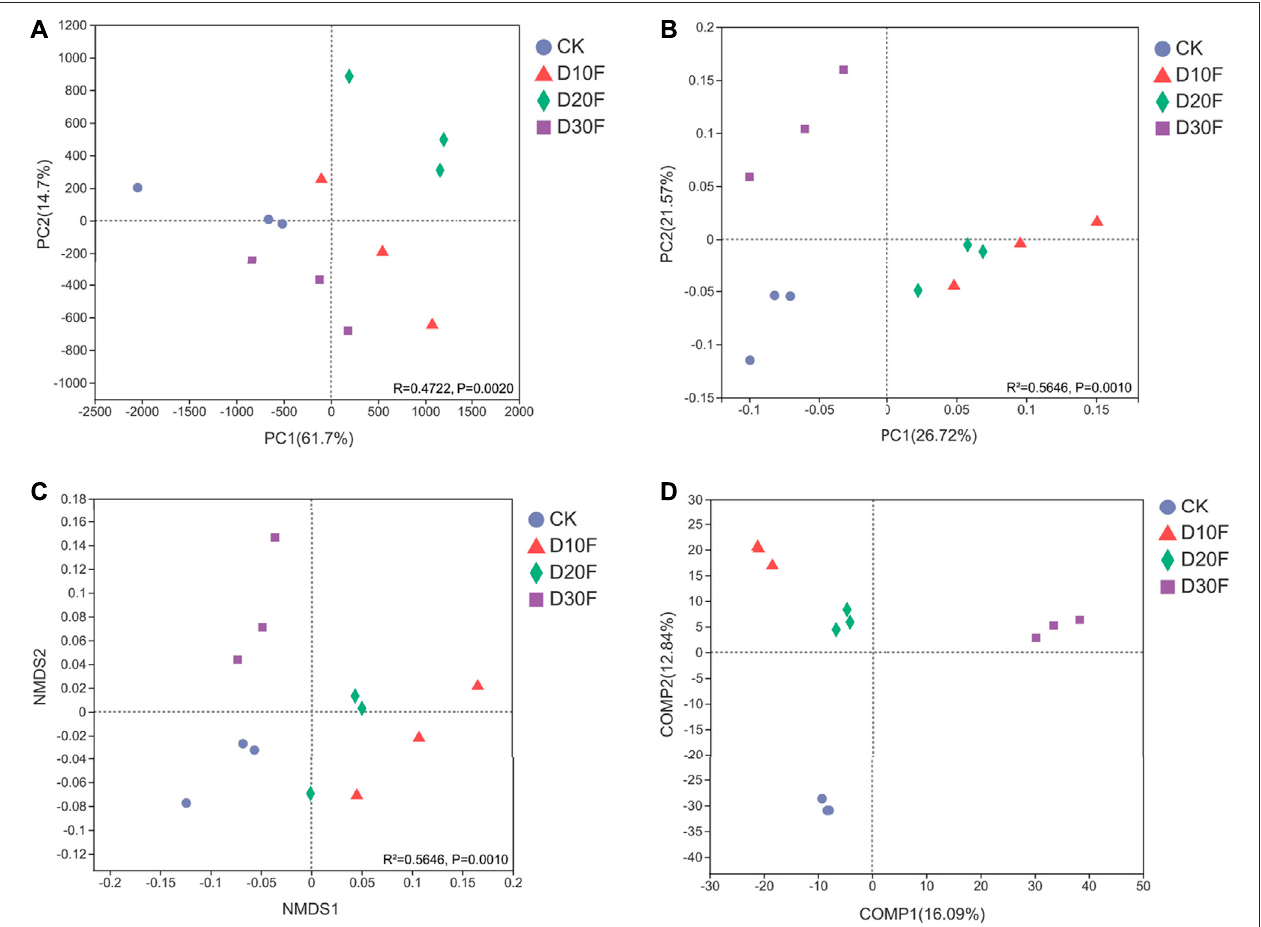
FIGURE3 | Combined plot integrated withthe PCA (A) , PCoA (B) , NMDS (C) , and PLS-DA (D) plots ofthe bacterial communities corresponding tobeta diversity.